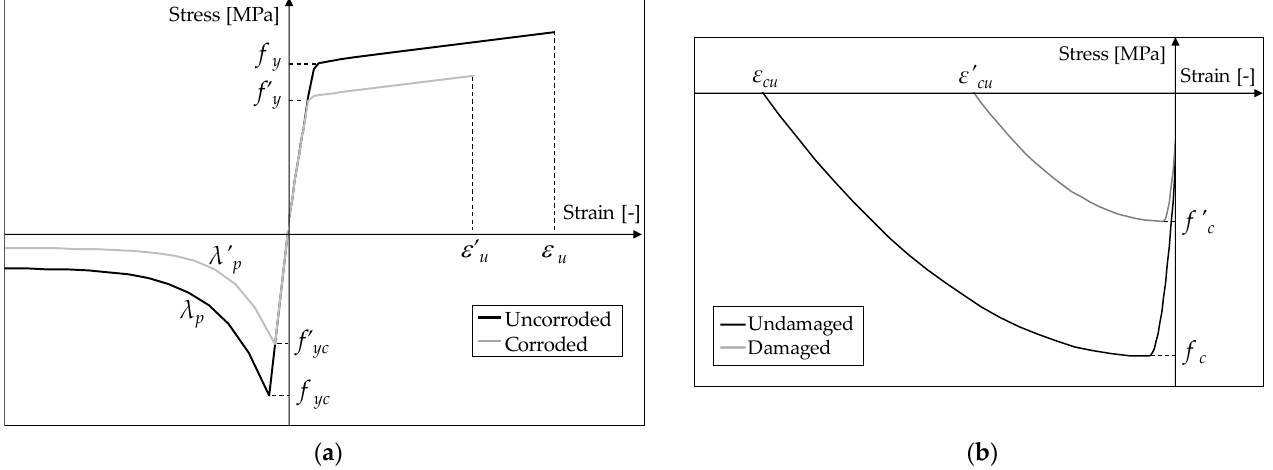
Figure 3. Constitutive relationship in case of corrosion: ( a ) reinforcing bars and ( b ) concrete.